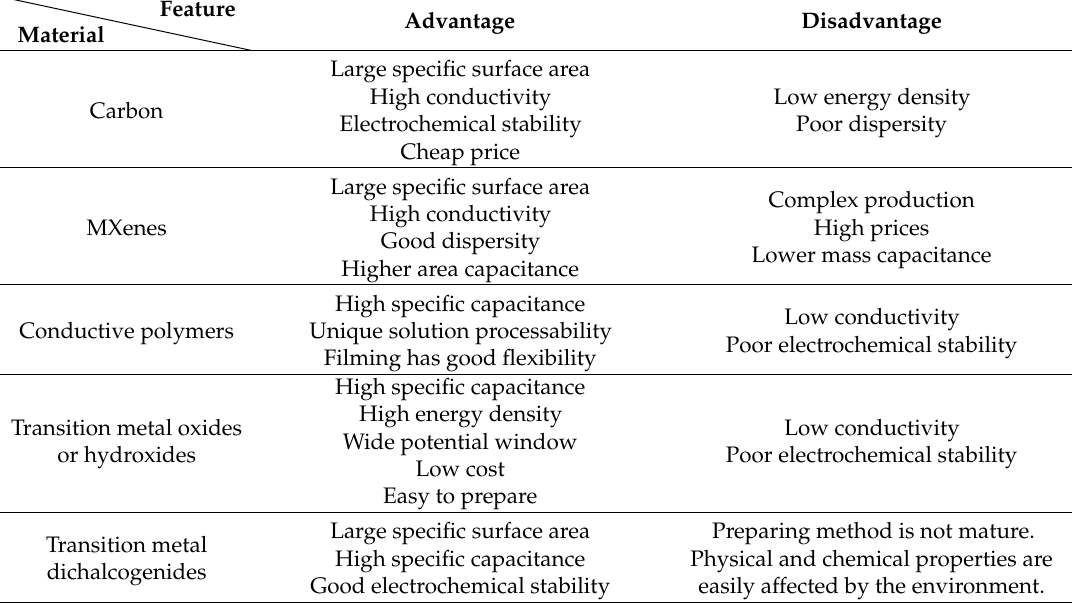
Table 1. Comparing the advantages and disadvantages of each type of